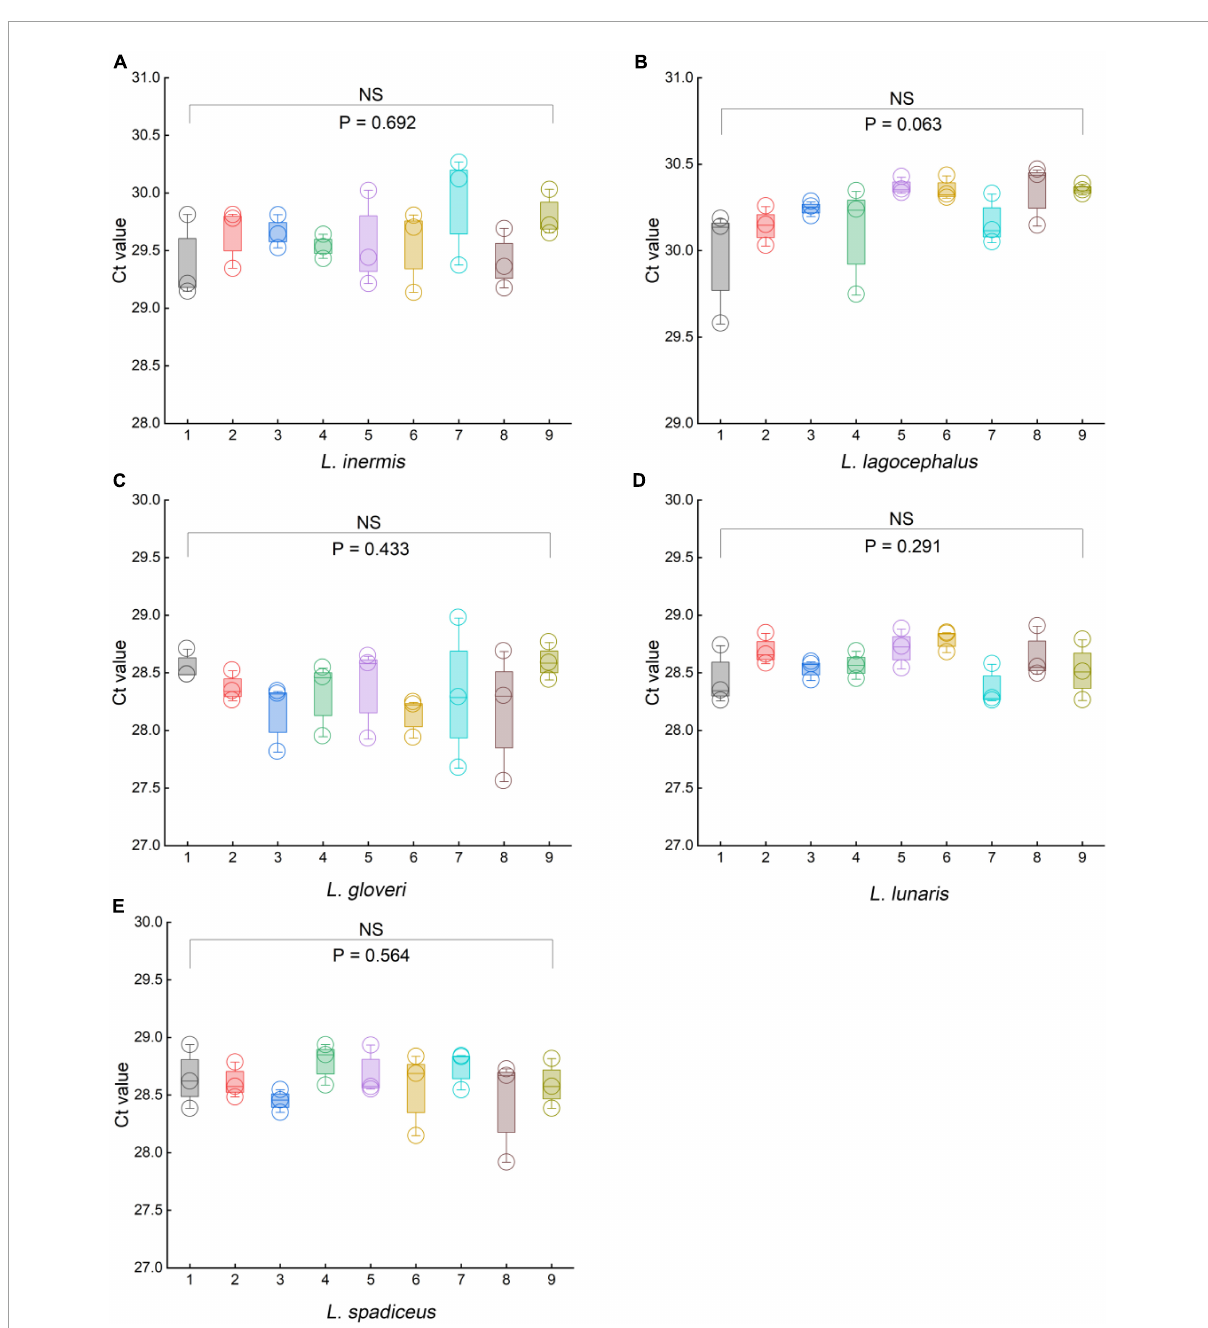
FIGURE6 Results of the robustness experiments for the specific of qPCR methods. (A) L. inermis , (B) L. lagocephalus , (C) L. gloveri , (D) L. lunaris , (E) L. spadiceus . In (A–E) , box plots are centered around the median. Minima and maxima are shown as the bottom and top of the box plots, respectively. All values are presented as mean ± s.e.m. Kruskal Wallis H test was used. NS, not